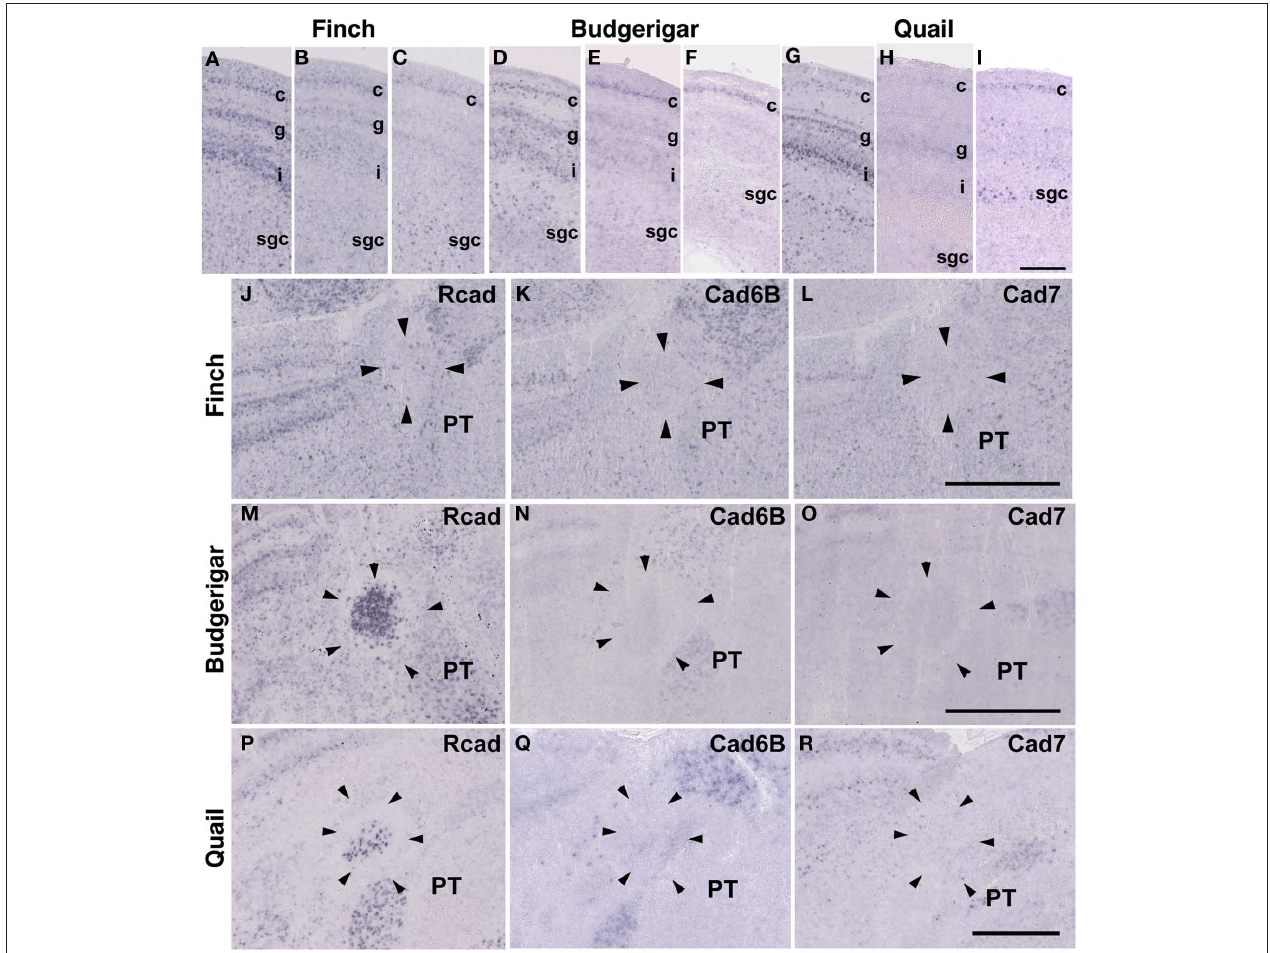
i of the stratum griseum et fibrosum superficiale (sfgs) and the stratum griseum centrale (sgc). (J–r) In situ hybridization for Rcad (J,M,P) , Cad6B (K,N,Q) , and Cad7 (L,O,r) of Bengalese finch (J–L) , budgerigar (M–O) , and quail (P–r) in the nucleus pretectalis (PT). Scale bars are 250 μm (i) and 500 μm